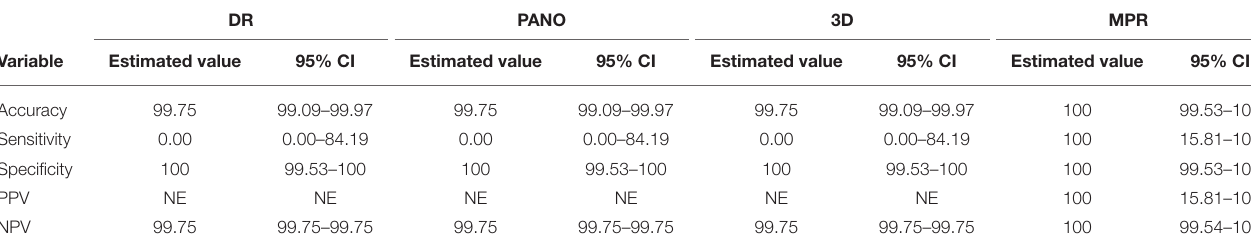
TABLE 11 | Ability to identify root replacement resorption in cats by use of dental radiography (DR method) and 3 CBCT software modules*.